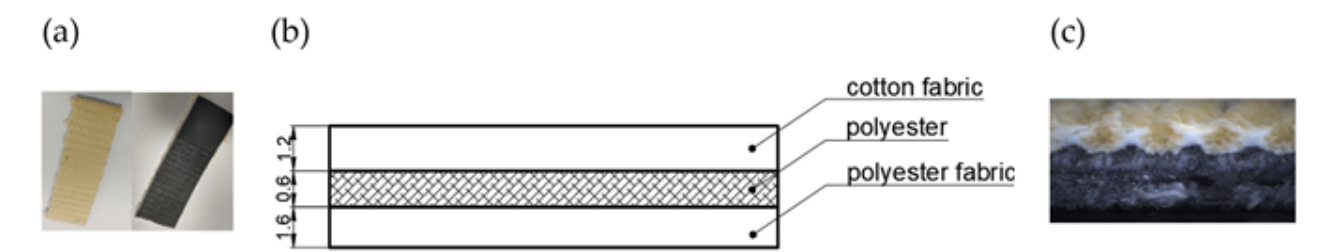
Figure 3. XH 500 flat lane ( a ) photography, ( b ) belt cross section, ( c ) optical light microscopy images of the internal structure.